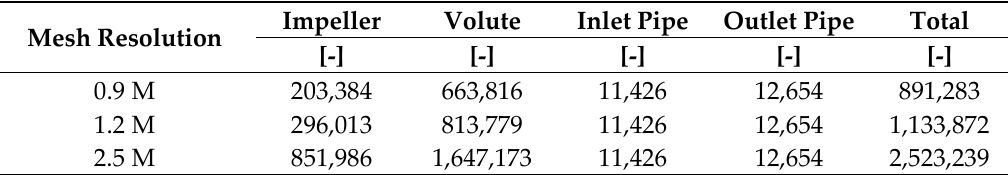
Table 1. Number of elements for each mesh resolution